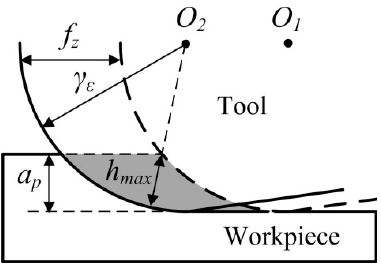
Figure 6. The maximum uncut chip thickness in micromilling.